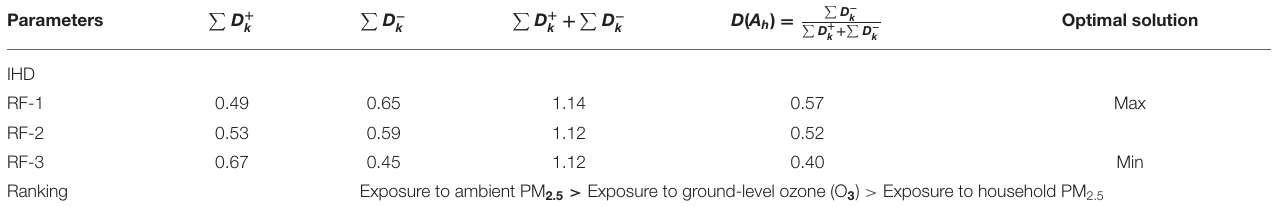
TABLE 7 | Estimated grey degree of synthetic assessment.